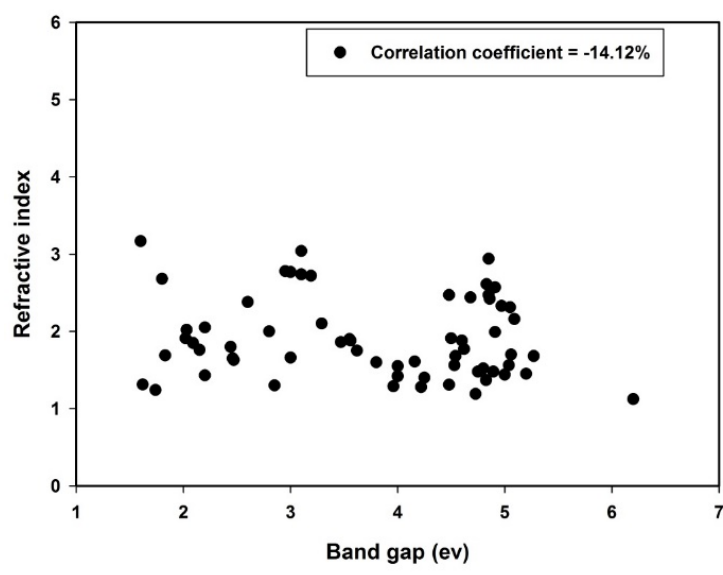
Figure 1. Correlation cross-plot between the descriptor and target.